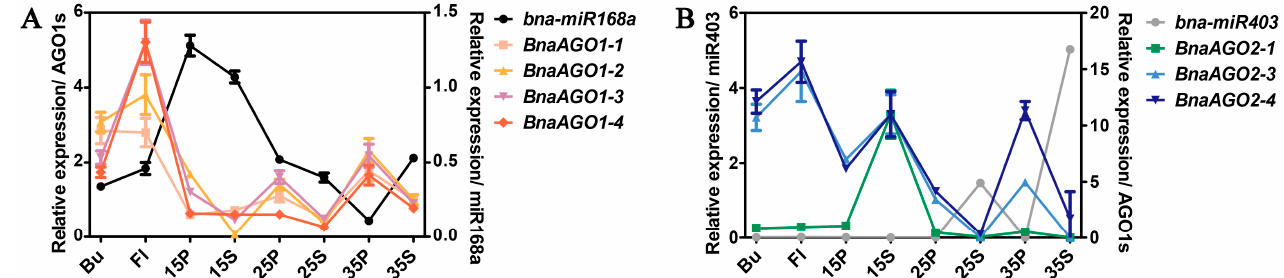
Figure 6. The qRT-PCR verification of the expression pattern between B. napus miR168a-AGO1s ( A ) and miR403-AGO2s ( B ) in materials ZS11. The numbers used in the labels on the x -axis (15, 25, and 35) means the days after flowering; Bu: bud; Fl: flower; P: pericarp; S: seed.